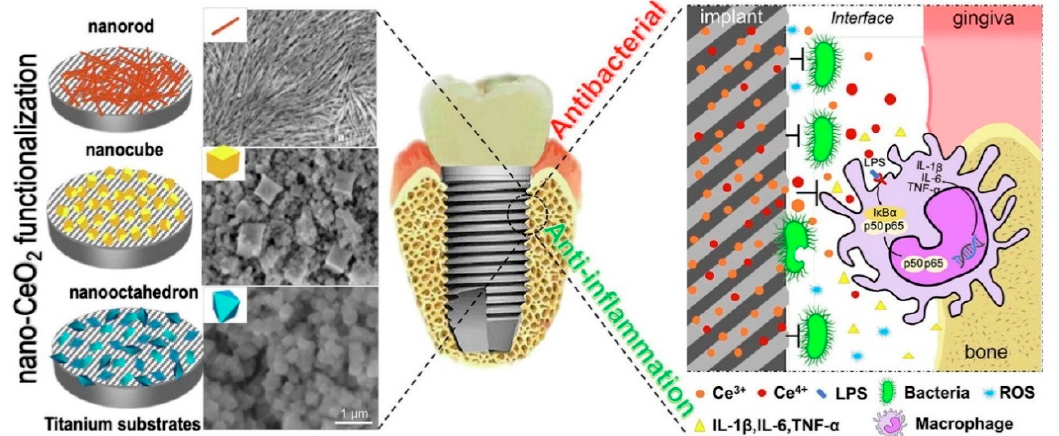
Figure 9. Schematic illustration of implant surface modified by CeO 2 nanoparticles for antibacterial and anti-inflammatory properties. The antibacterial effects depend on positively charged CeO 2 nanoparticles could probably affect negatively charged bacterial cell surface by electrostatic attraction. In addition, CeO 2 nanoparticles inactivate surface protein and decrease the permeability of bacterial cell membranes. For anti-inflammatory properties, CeO 2 nanoparticles have both catalase (CAT) and SOD (superoxide dismutase) activities [150]. Copyright 2019 Acta Materialia Inc.